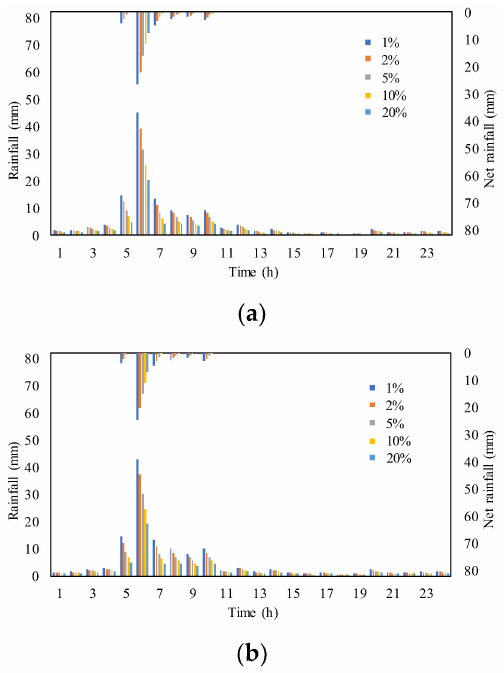
Figure 9. Hyetograph of design rainstorms and net rainfall: Anding ( a ), Qiangjiawan ( b ). According to the process of net rainfall, the design flood hydrographs with different frequencies were calculated by the instantaneous unit hydrograph and the curves are drawn in Figure